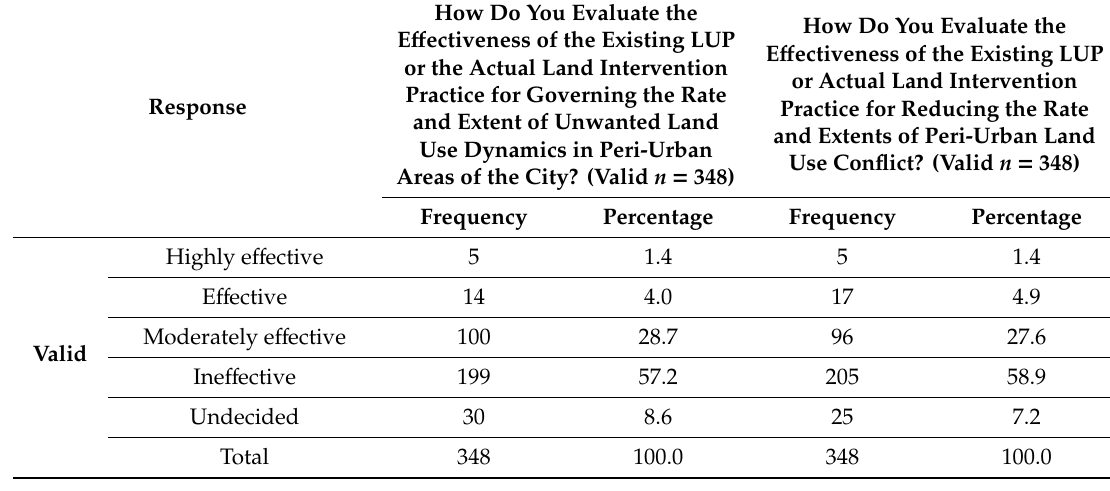
Table 5. E ff ectiveness of the existing LU framework for governing the rate and extents of land use dynamics and land use